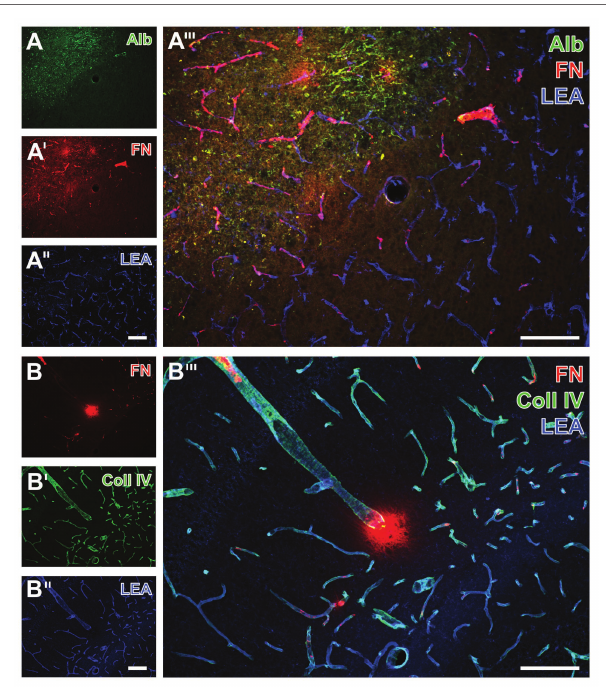
FIGURE 1 | Fluorescence-based visualization of impaired blood-brain barrier integrity with vascular elements as well as collagen IV and fibronectin in mice subjected to 24 h of focal cerebral ischemia. Extravasation of (endogenous) serum albumin (Alb, A ) into brains’ parenchyma is visible in conjunction with an increased immunosignal of fibronectin (FN, A ' ) as a component of the extracellular matrix (ECM). FN also appears in close vicinity to collagen IV (Coll IV, B ' ) as part of the basement membrane 24 h after ischemia onset. FN is thereby visible in the striatum (A) and the hippocampus (B) . In the area of ischemia, immunosignals for Alb (A) and fibronectin (A ' ,B) are associated with endothelia, as detected by the lectin-staining with LEA (A '' ,B '' ) , and are visible within the adjoining neuropil in a carpet-like manner. Ischemia-affected tissue selectively exhibits a strong immunosignal for Coll IV (B ' ) . The overlay of staining patterns clearly reveals the border of ischemic affection (A ''' ) and different forms of vessel-associated focal condensation of FN. Scale bars: in A ''' and B ''' = 100 μ m, in A '' (also valid for A and A ' ) and B '' (also valid for B and B ' ) = 100 μ